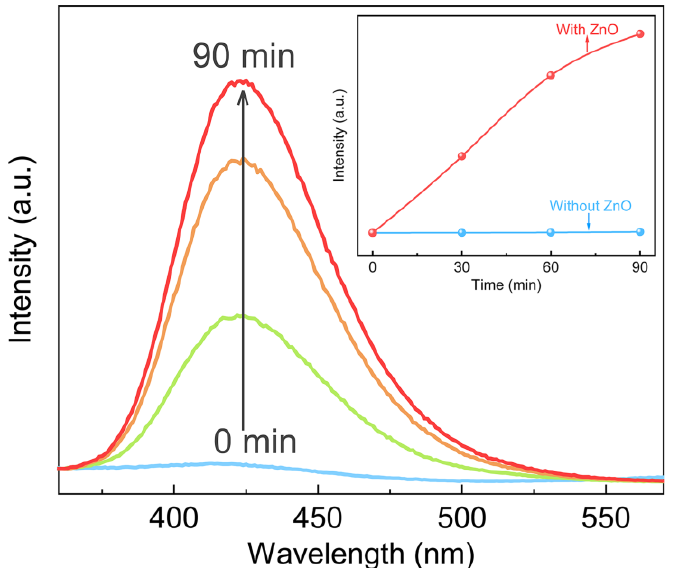
Figure 5. Comparison for tribocatalytic performance of ZnO-3: ( a ) With different shapes of PTFE- sealed magnetic rotating disk, ( b ) with the addition of various scavengers.